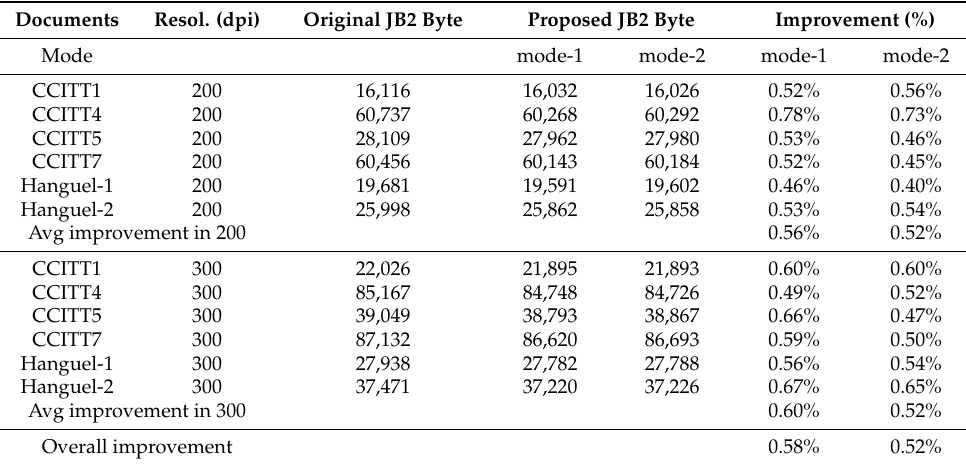
Table 14. 2-level LUT experimental results for JBIG2. ( α = β =